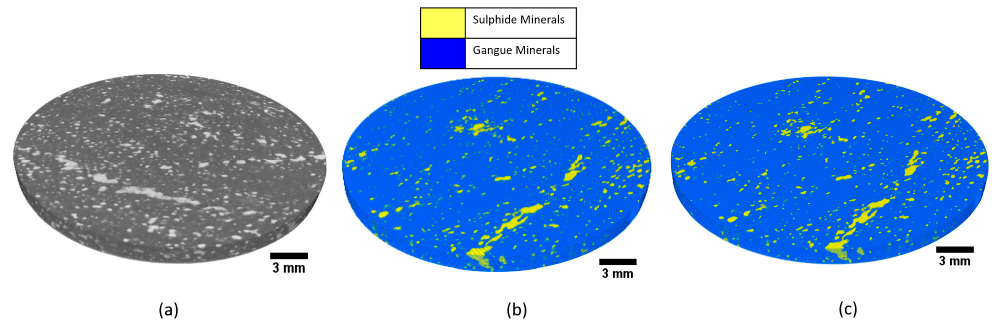
Figure 7. ( a ) Original drill core volume obtained from µCT; ( b ) multilevel Otsu thresholding, showing 10% of sulphide mineral grain content; and ( c ) K-means segmented image, showing 6.3% of sulphide mineral grains content. While the images look similar, there exists a relatively significant difference between the amount of grains segmented using both techniques.